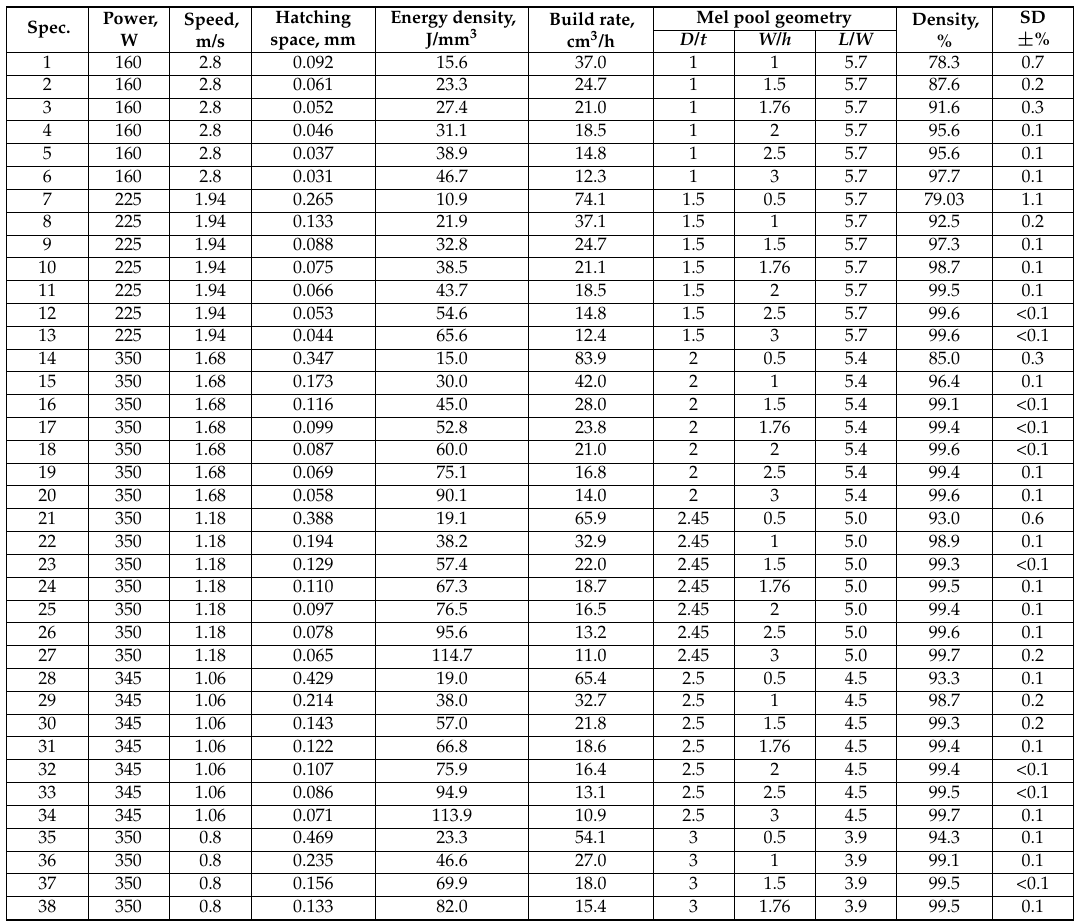
Table A1. Printing parameters, melt pool geometry and density of IN625 test coupons (M280 EOS).